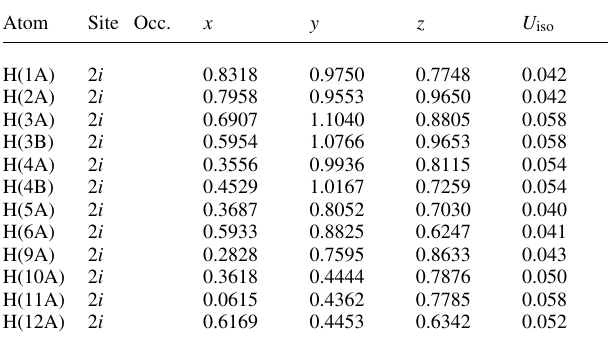
Table 2. Atomic coordinates and displacement parameters (in Å 2 )